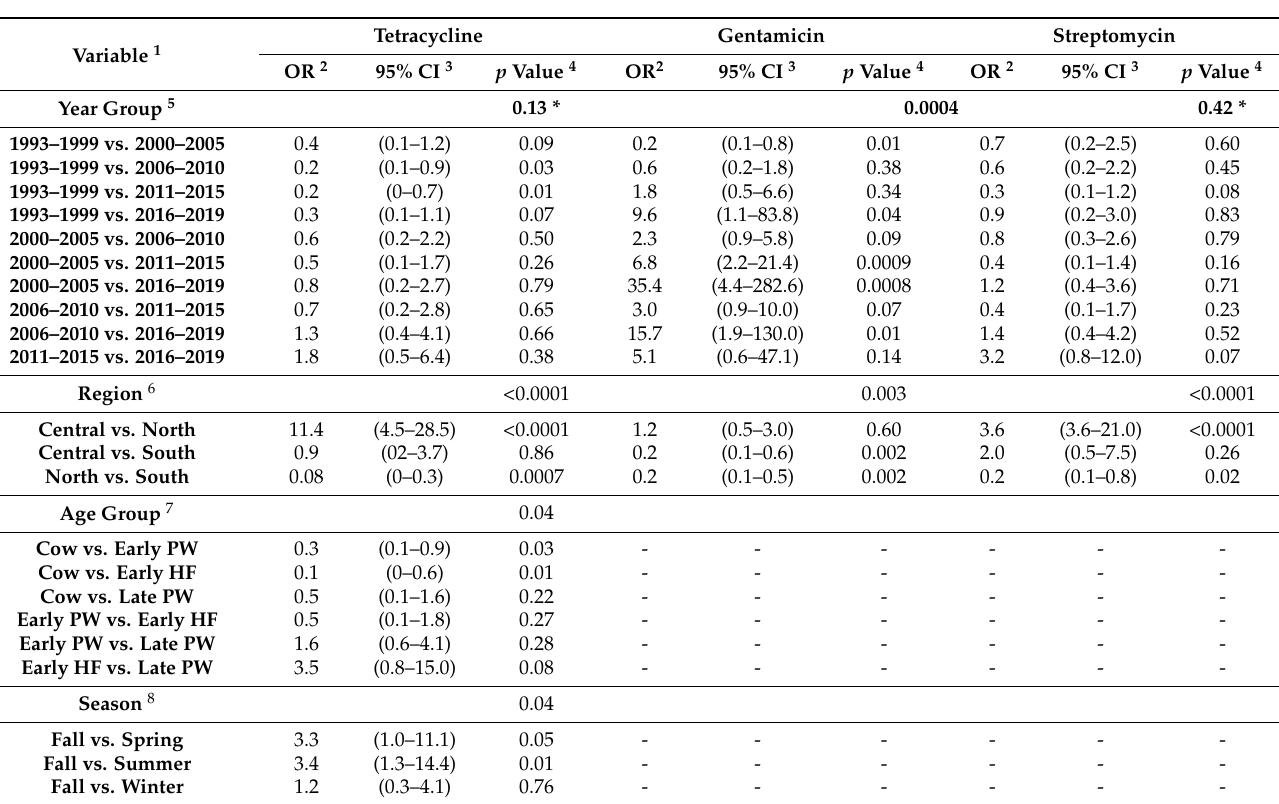
Table 6. Odds ratio for the effect of year group and region for S. Dublin classified as resistant for tetracyclines and aminoglycosides in the NARMS panel. p values in bold indicate significant odds ratio